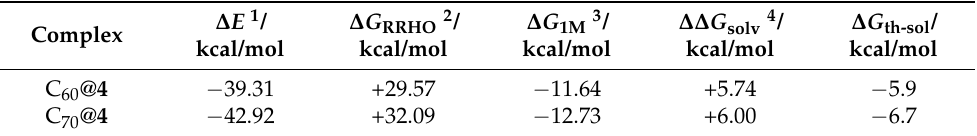
Table 5. Theoretical binding free energies ( ∆ G th-sol ) for complexation of 4 with fullerenes in toluene at 298